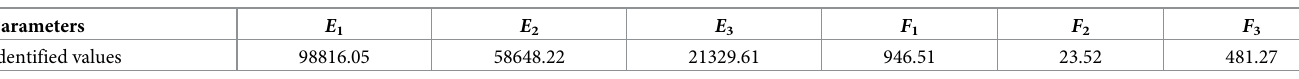
Table 2. Identified parabolic parameters of the developed oxidation kinetic